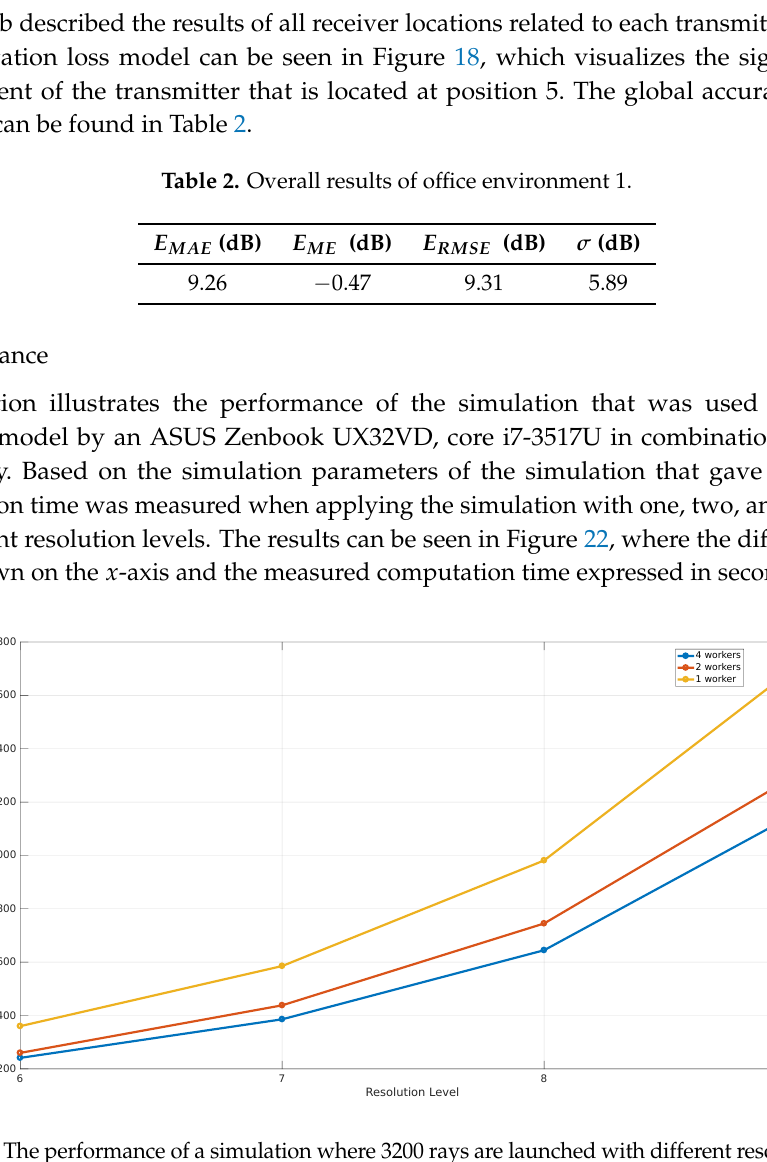
Figure 22. The performance of a simulation where 3200 rays are launched with different resolution